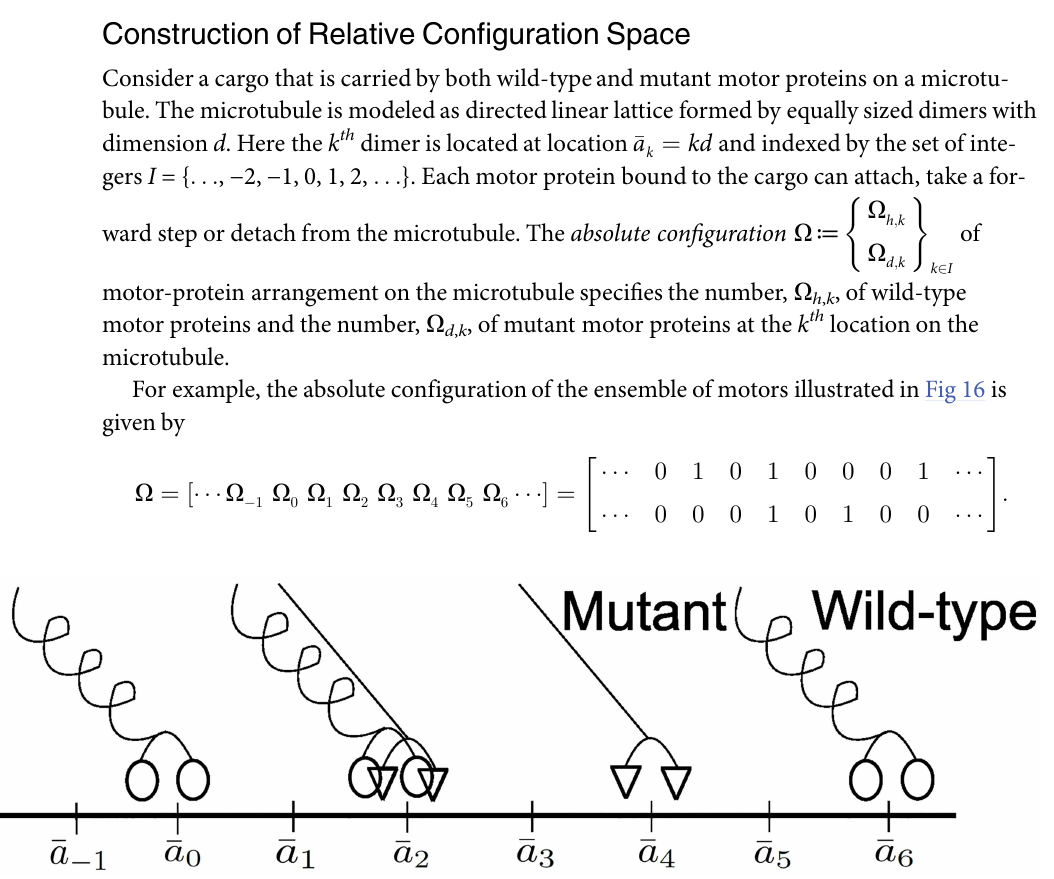
Fig 16. Locations of wild-type and mutant motors on a section of the microtubule lattice. The microtubuleis modelled ¼ (cid:22) a þ kd , where (cid:22) a as a directed linear lattice (cid:22) a is the position of the k th location. If all the motors carry a common cargo i.e. 0 k k the wild-typemotor at a 0 is the rearguardmotor, the string representation is | M h || M h M d || M d || M h